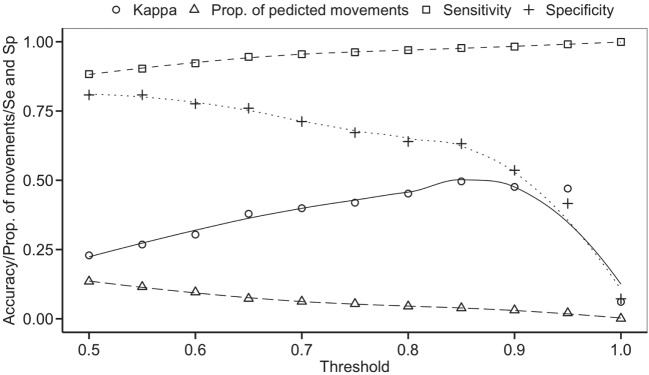
Kappa statistic accompanying the threshold probability for the proportion of predicting movements out of the total pairs using balanced data. Sensitivity (Se) and specificity (Sp) are also reported through different thresholds.